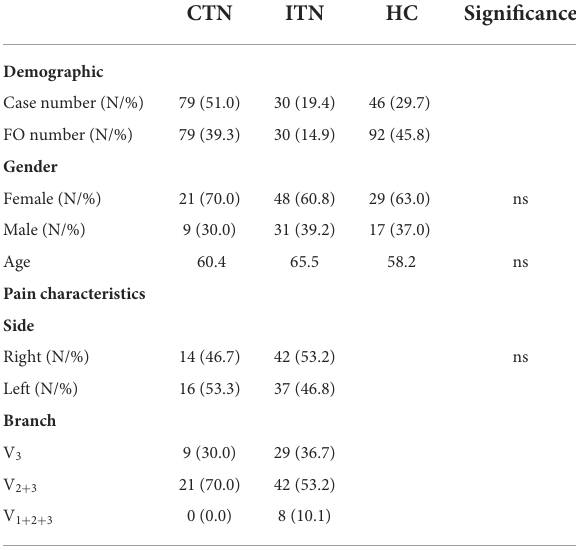
TABLE 1 Demographic and pain characteristics of HC, CTN and ITN